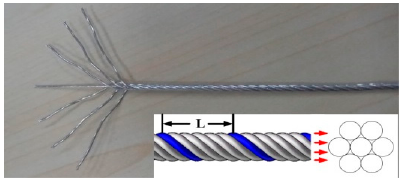
Figure 1. Schematic of welding wire.